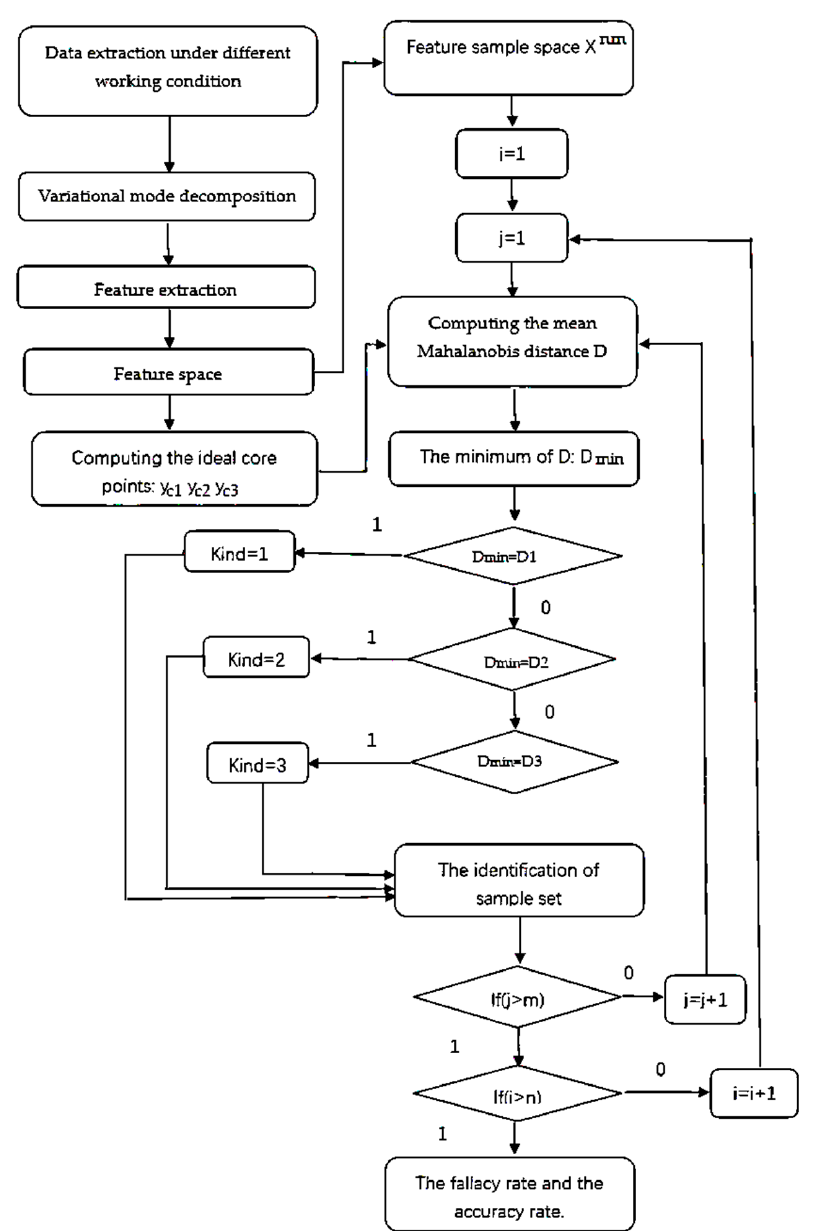
Figure 11. N-S flow chart.